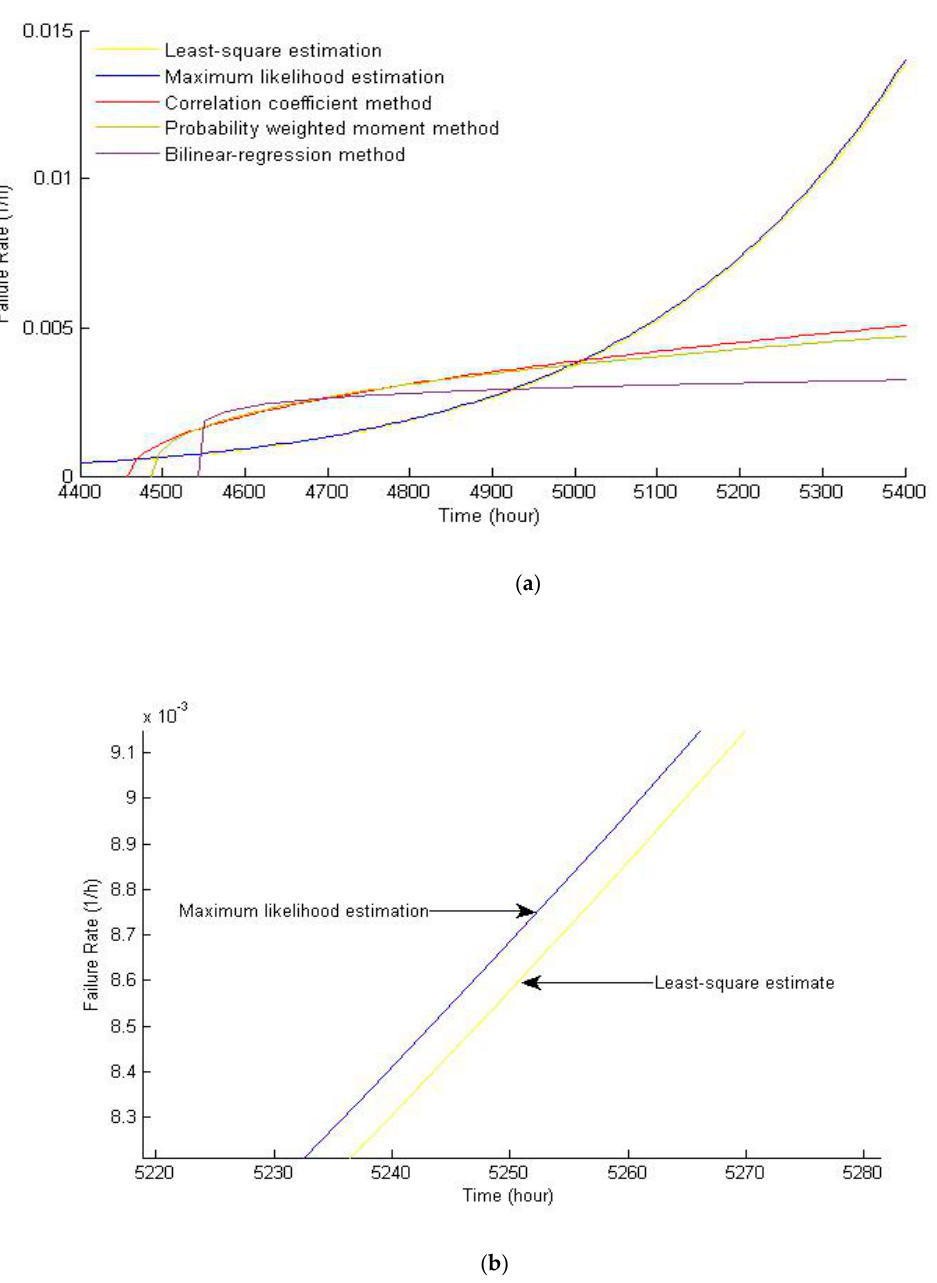
Figure 2. Failure-rate curves of Weibull distributions. ( a ) Comparison of failure rate for three- and two-parameter Weibull distributions. ( b ) Partial enlarged drawing of maximum likelihood estimation and least-squares estimation.